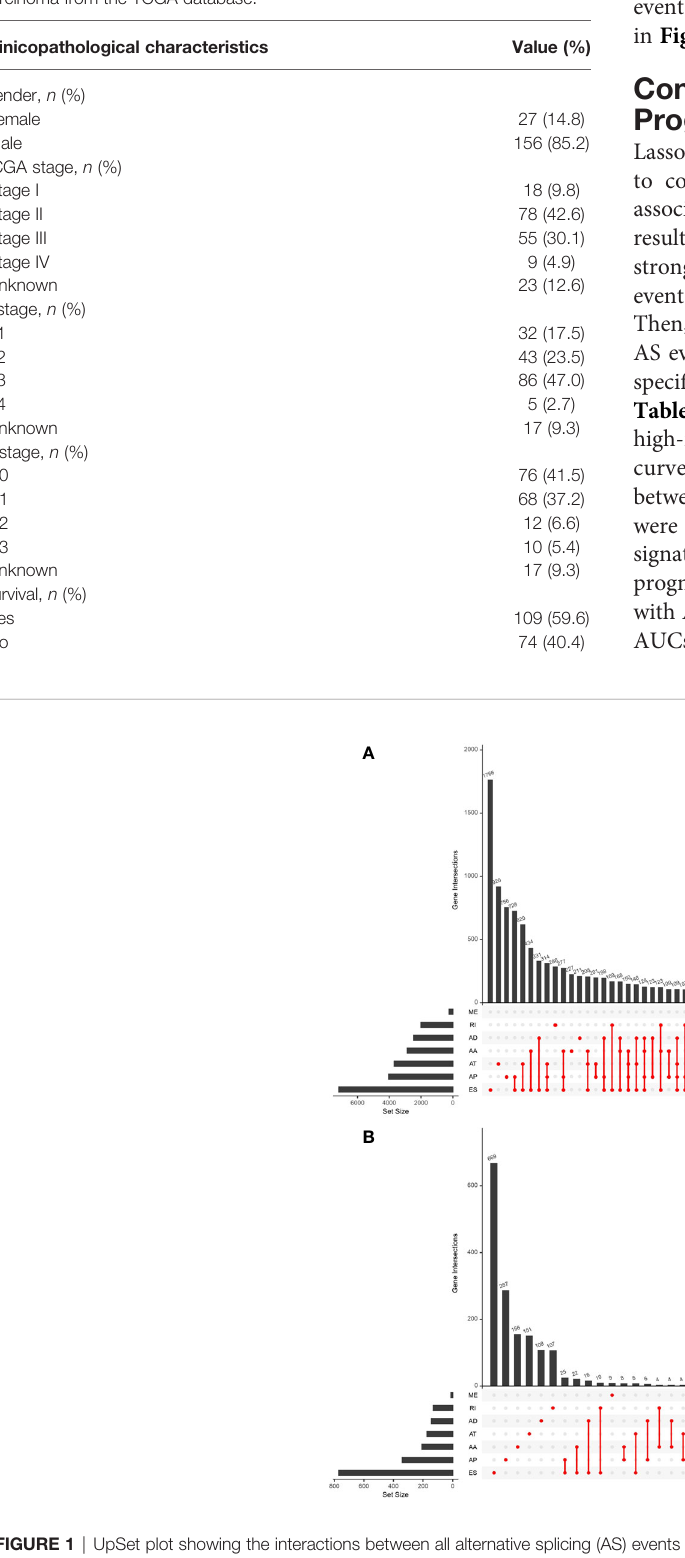
FIGURE 1 | UpSet plot showing the interactions between all alternative splicing (AS) events and parental genes (A) and the interactions between AS events associated with survival and corresponding parental genes (B) in esophageal carcinoma (EC) patients. Usually, several AS events occurred in a single gene.